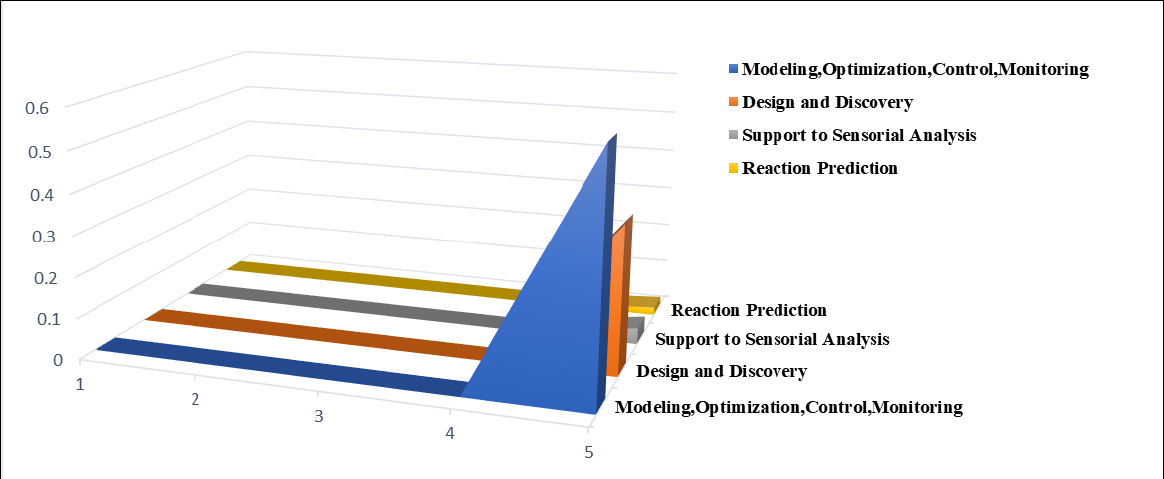
Figure 3. Application of supervised learning in the chemical industry.